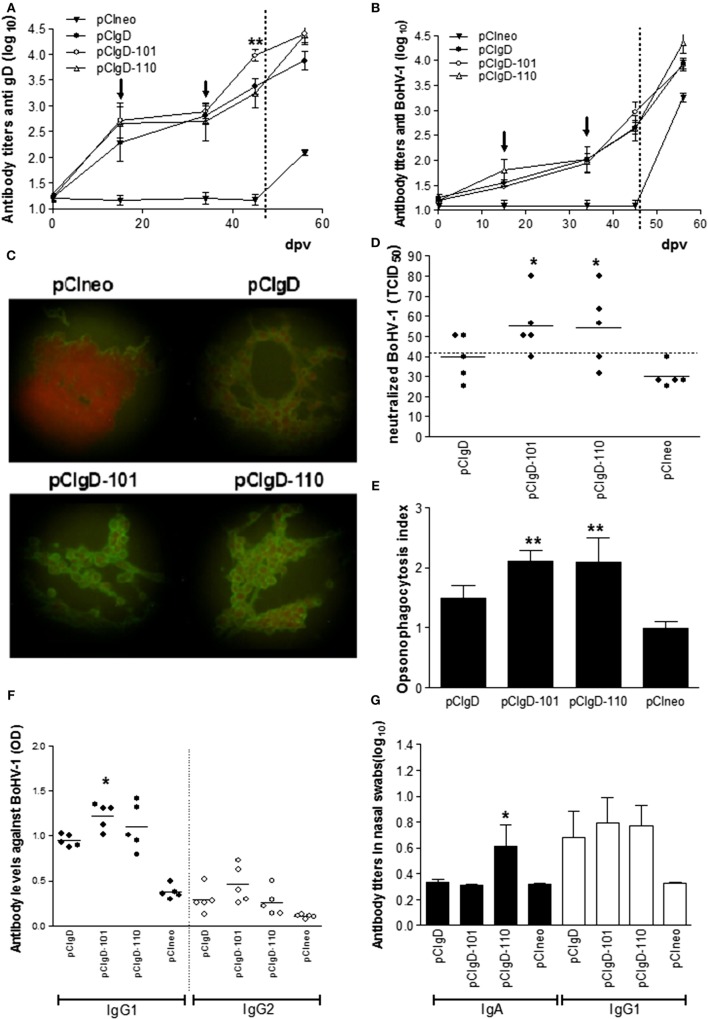
Antibody against bovine herpesvirus (BoHV-1) elicited by vaccines. (A) Antibody titers measured by ELISA using recombinant gD as antigen. (B) Antibody titers measured by ELISA using inactivated BoHV-1 as antigen. Dotted line represents the challenge day. Each point represents the mean titer ± SEM of the group for each date. Arrows indicate the date at which booster vaccination was performed. The cutoff was calculated as the mean level of antibodies at 0 days post vaccination (dpv) +2 SD. (C) Microscopy analysis of cells infected with BoHV-1 and incubated with sera from vaccinated and unvaccinated animals. One representative serum from each group is shown. (D) Each point represents the TCID50 neutralized using a 1:12 dilution of each serum at 44 dpv. The dotted line represents the cutoff point calculated as the mean level of antibodies in pCIneo group +2 SD. Solid line represents the mean TICD50 neutralized in each group (E) Opsonizing capacity of sera (from 44 dpv) measured by flow cytometry as % of BoMac cells incorporating FITC-virus after incubation with sera from vaccinated animals. Opsonizing index was calculated as: % FITC-charged cells in each group/mean % of FITC-charged cells in pCIneo group. Each bar represents the mean titer + SEM of opsonizing indexes in each group. (F) Isotype profile of antibodies against BoHV-1, measured by ELISA at 44 dpv. Each point represents the OD of one animal serum in a 1/50 dilution, solid line represents the mean titer of each group. Black dots represent IgG1 isotype and white dots represent IgG2 isotype. (G) Isotype profile of antibodies against BoHV-1, measured by ELISA at 44 dpv. Each bar represents the mean titer + SEM. Black bars represent IgGA isotype and white bars represent IgG1 isotype. Significant differences (*p < 0.5 or **p < 0.01) compared to pCI-gD group.